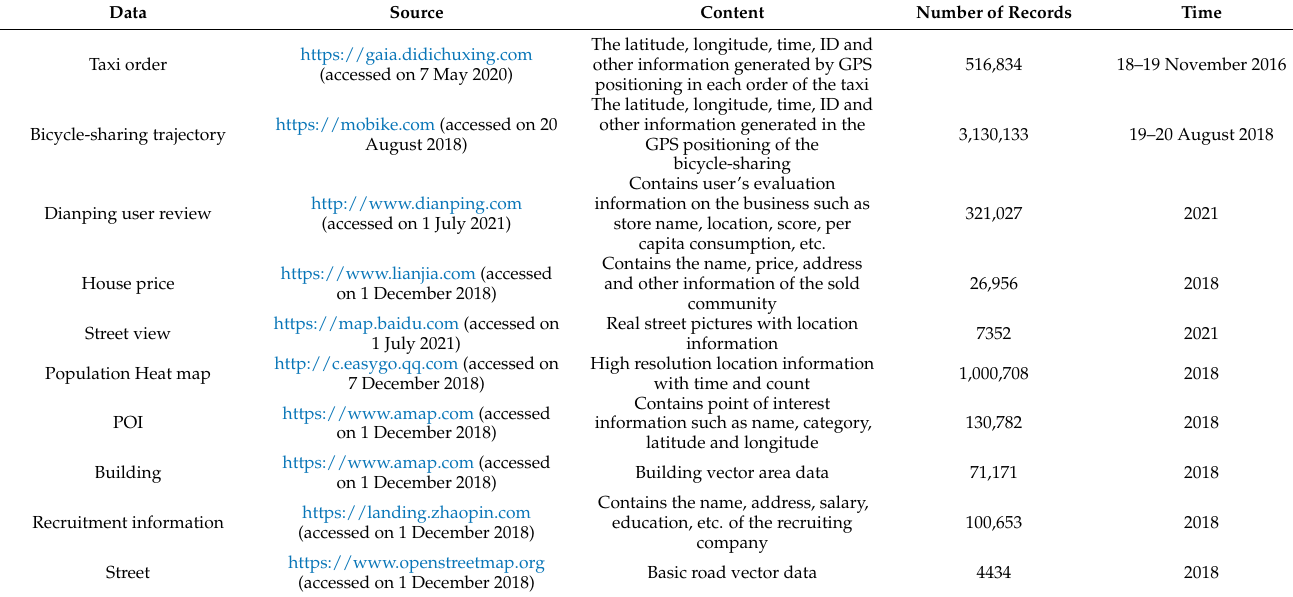
Table 1. Detailed description of the study